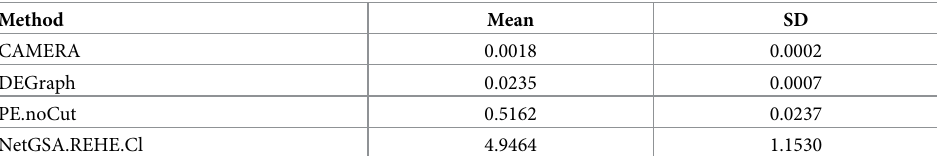
Table 2. Timing results (in minutes) comparing NetGSA with REML and REHE to select methods for breast can- cer data.